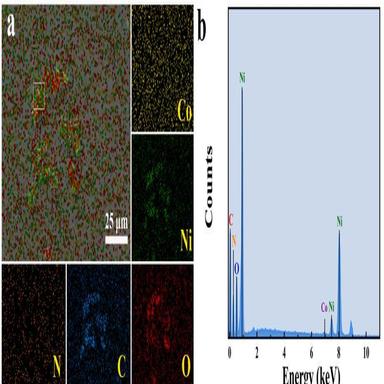
EDS mapping images (a) of N/NC-10 and the EDS spectrum (b).